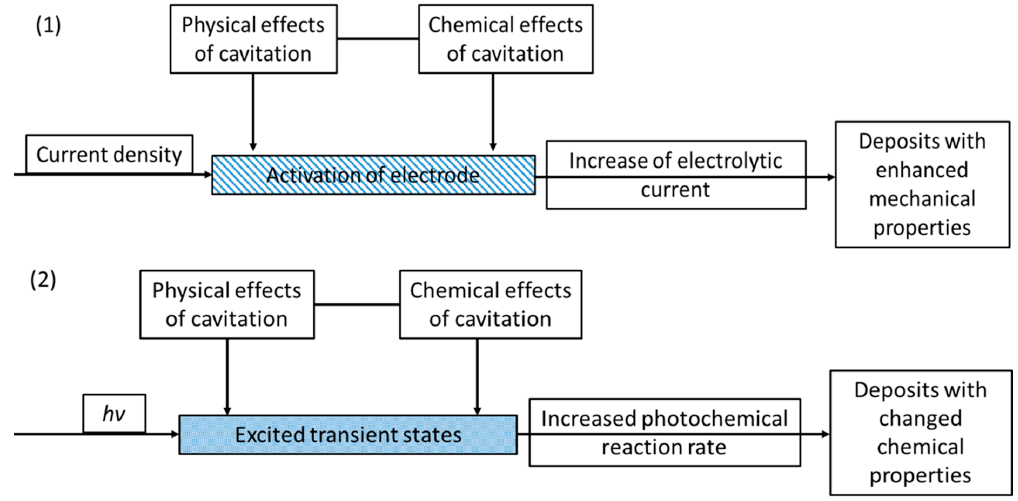
Figure 14. Schematic representation summarizing both (1) sonoelectrodeposition and (2) sonophotodeposition processes. (2) sonophotodeposition